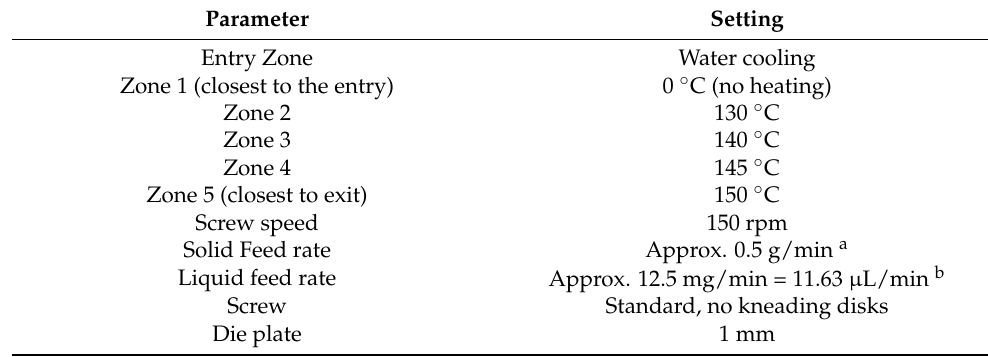
Table A2. ASD production settings on a Three-Tec (Seon, Switzerland) ZE9 9 mm mini extruder.